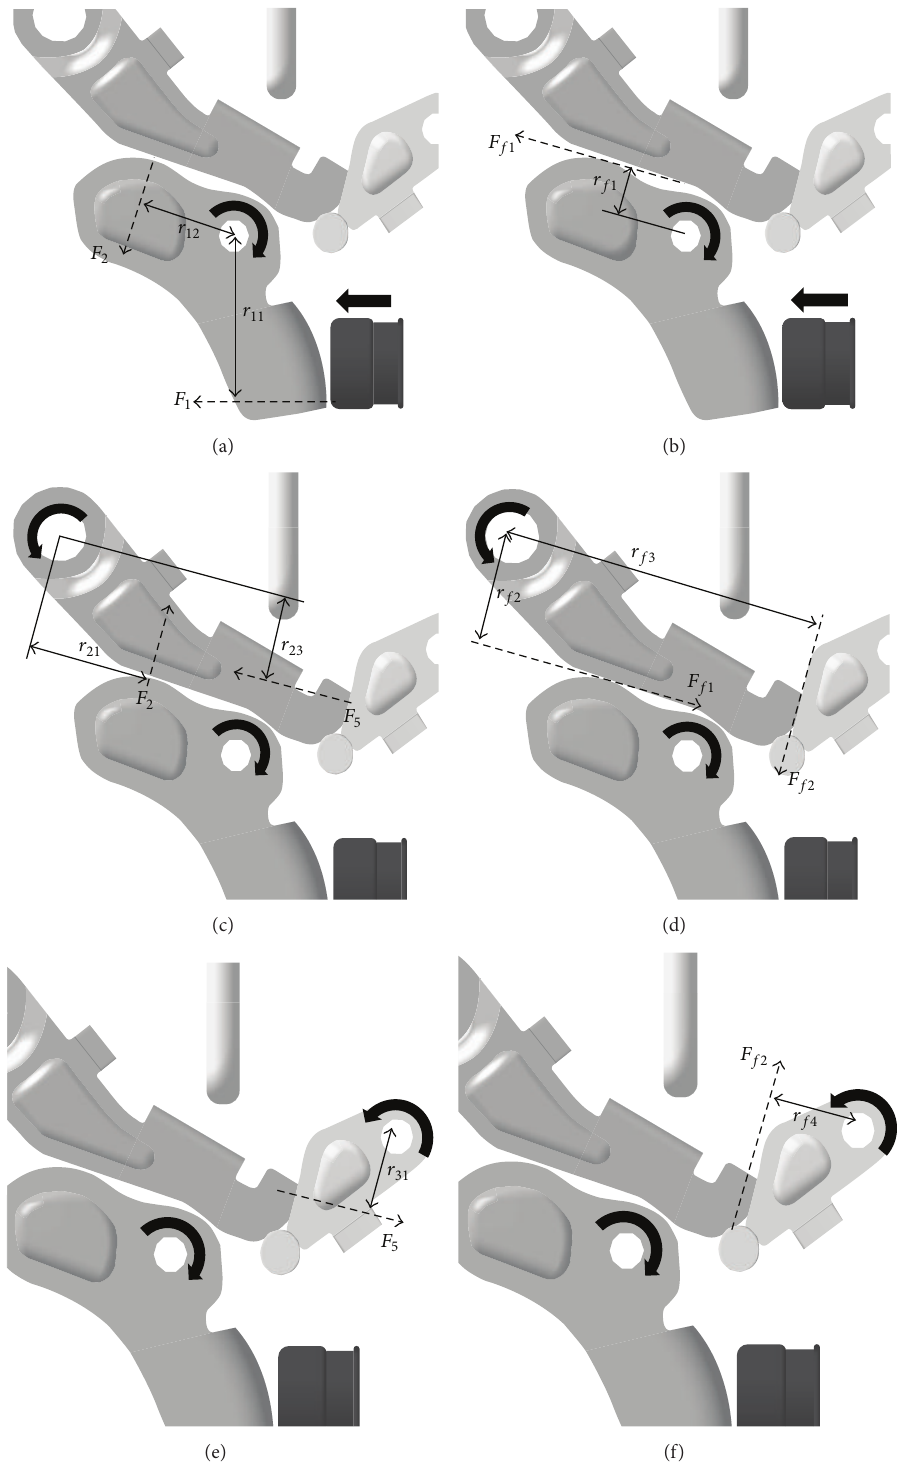
Figure 8: Free body diagram for solving moment at step 1: (a) free body diagram showing forces of bracket release, (b) free body diagram showing friction force of bracket release, (c) free body diagram showing forces of pop-up guide, (d) free body diagram showing friction forces of pop-up guide, (e) free body diagram showing force of emergency pawl, and (f) free body diagram showing friction force of emergency